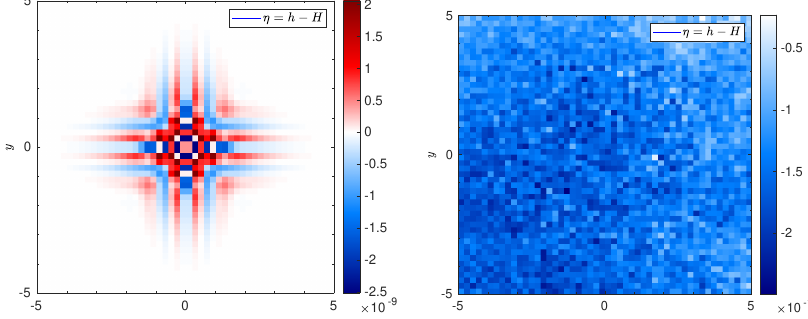
Figure 13. Computed free surface for the stationary problem (68) (dispersive Gavrilyuk–Favrie equations) at time t = 10 s with the fourth-order non-well-balanced ( left ) and well-balanced ( right ) methods. A uniform Cartesian mesh of N x × N y = 50 × 50 elements has been used. Upper and lower panels stands for Runge–Kutta and ADER time-marching discretisations, respectively.